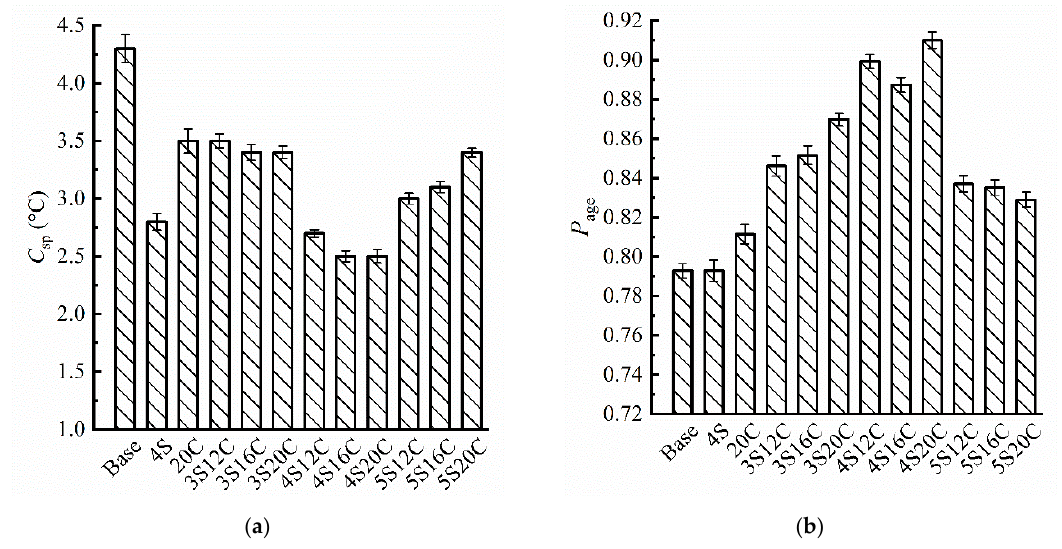
Figure 6. Evaluation indexes of basic properties: ( a ) the change of softening point ( C sp ), and ( b ) the change percent of penetration ( P age